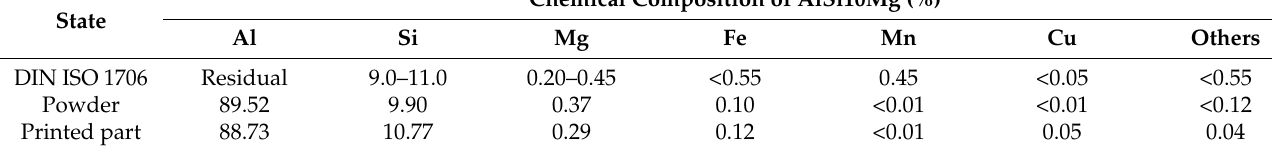
Table 1. Chemical composition of the used powder according to the powder batch test report and the part after 3D printing by L-PBF, measured by emission spectroscopy of type BRUKER Q4 Tasman, in comparison to DIN ISO 1706:2020